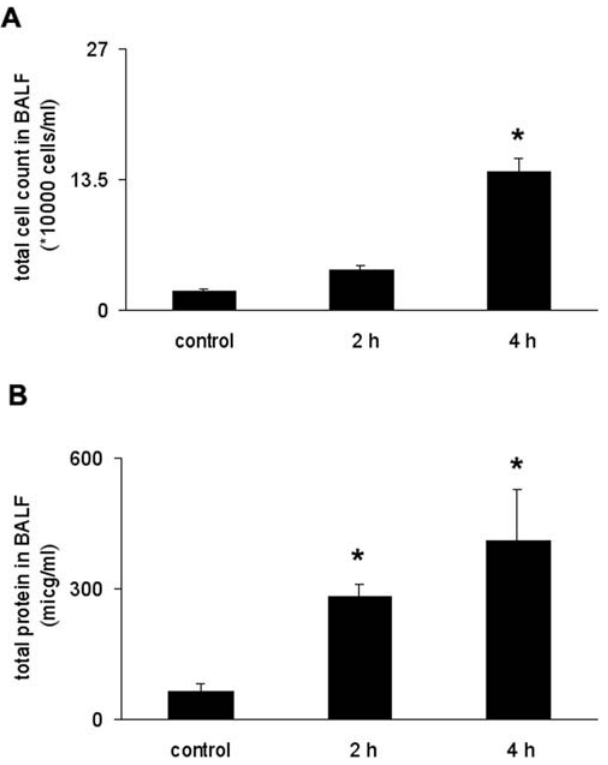
Figure 2. Time course of mechanical ventilation-induced lung injury with high tidal volume. (A) Total cell count increased following ventilation (20 ml/kg) for 2 and 4 hours (*10000 cells/ml). (B) BALF total protein levels (microgram/ml) were augmented by mechanical ventilation. *represents significant differences between ventilated and control animals, p , 0.05.